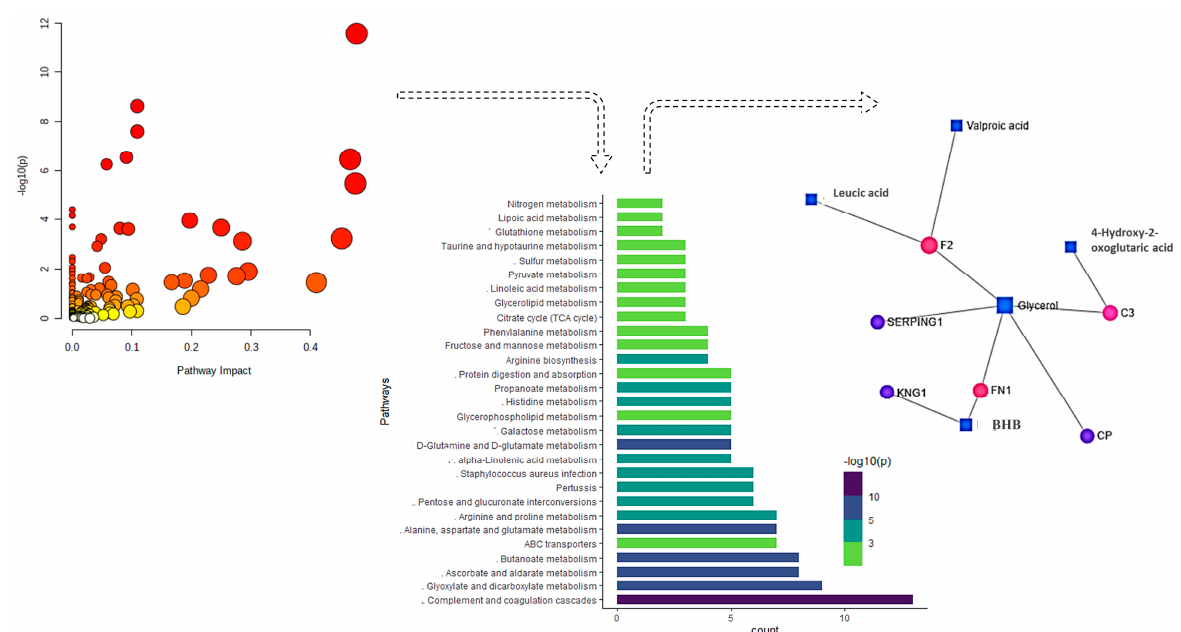
Figure 7. Joint pathway analysis represented all matched FDR-enriched pathways based on the pathway enrichment method and pathway impact values. Furthermore, gene-metabolite interaction analysis was used to map all the correlated proteins and metabolites, leading to the identification of one subnetwork with 11 nodes and 10 edges.